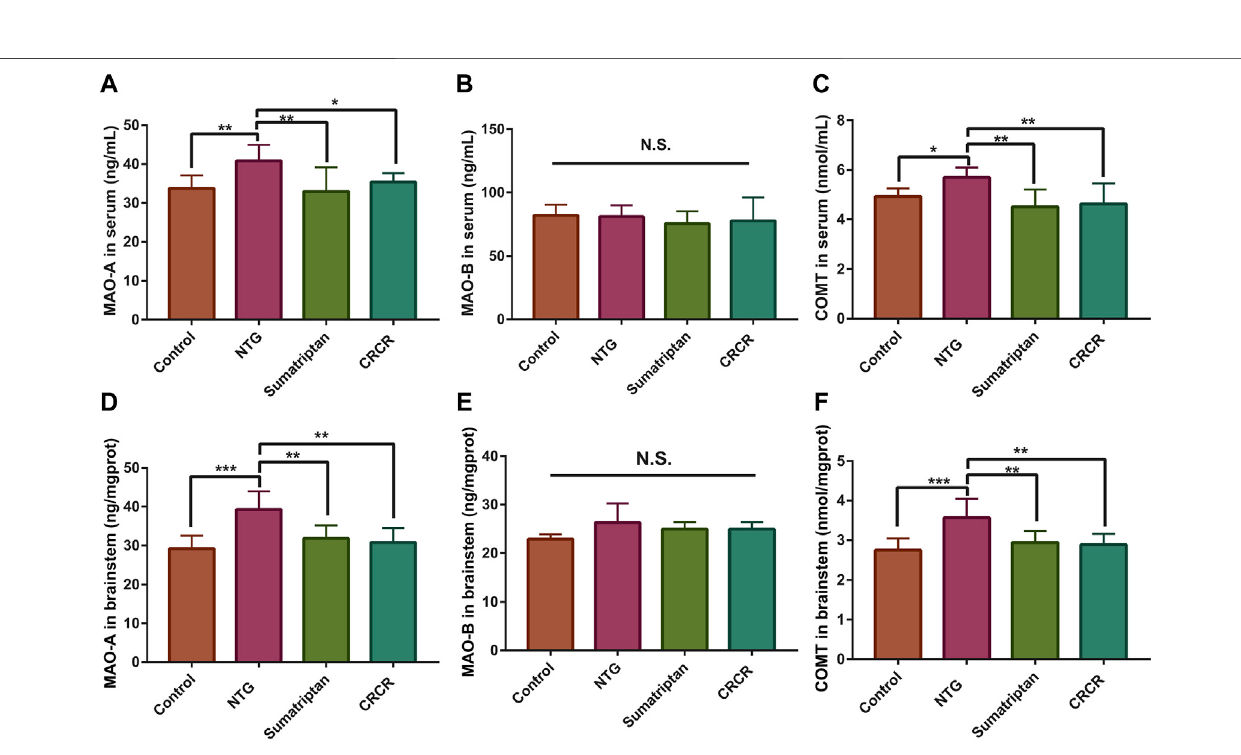
Frontiers in Pharmacology |